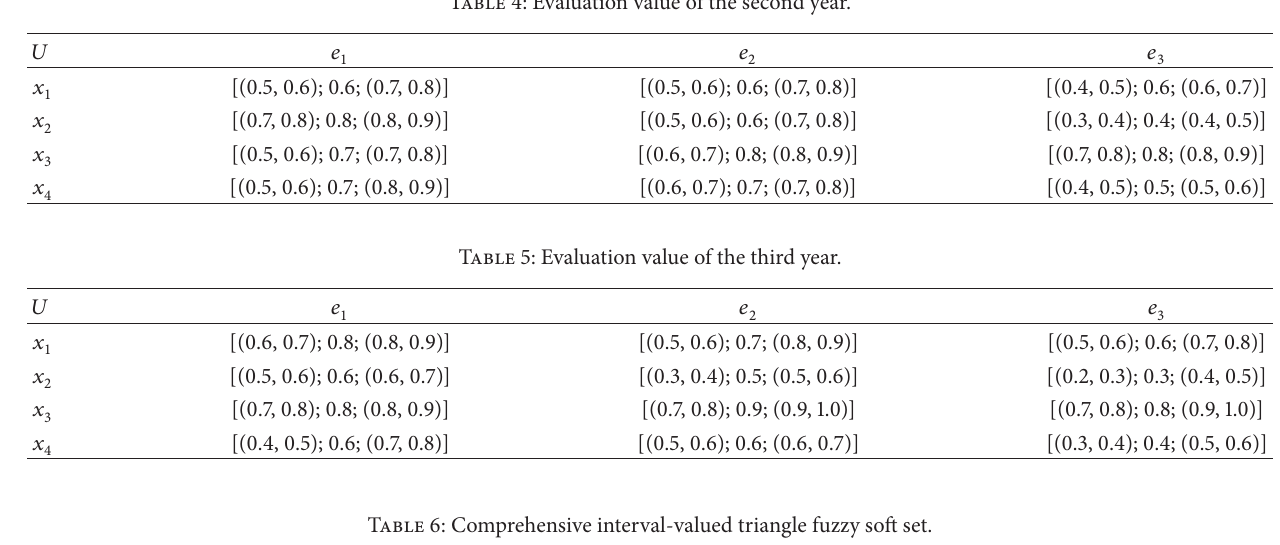
Table 4: Evaluation value of the second year.